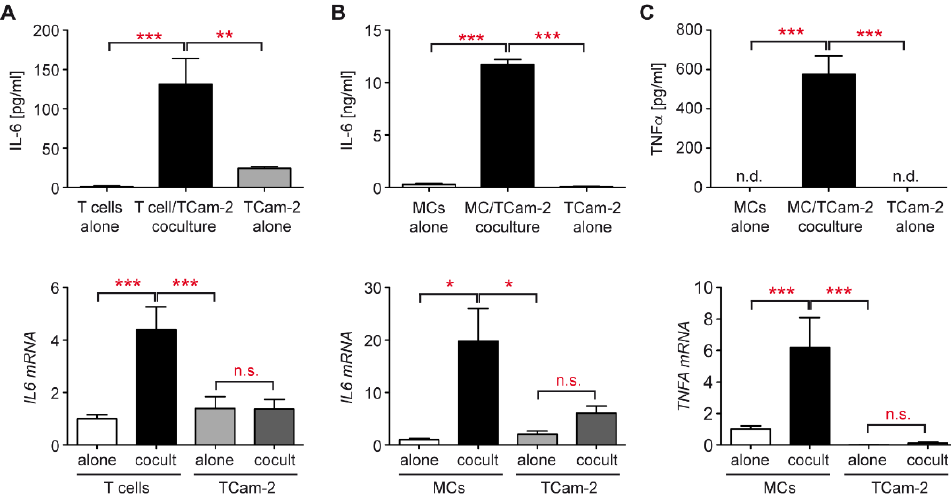
Figure 5. Analysis of cytokine secretion and release in immune cell cocultures with TCam ‐ 2 cells. T cells or monocytes (MCs) were isolated from PBMC of healthy blood donors using magnetic cell sorting and cultured in 6 ‐ well plates on a monolayer of TCam ‐ 2 cells for 24 h. T cells, MCs, and TCam ‐ 2 cells cultured alone served as controls. Supernatants were harvested for the analysis of se ‐